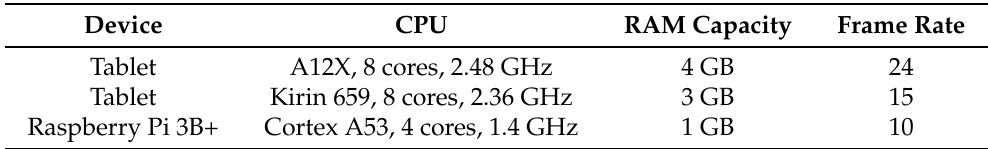
Table 1. Tested devices and obtained frame